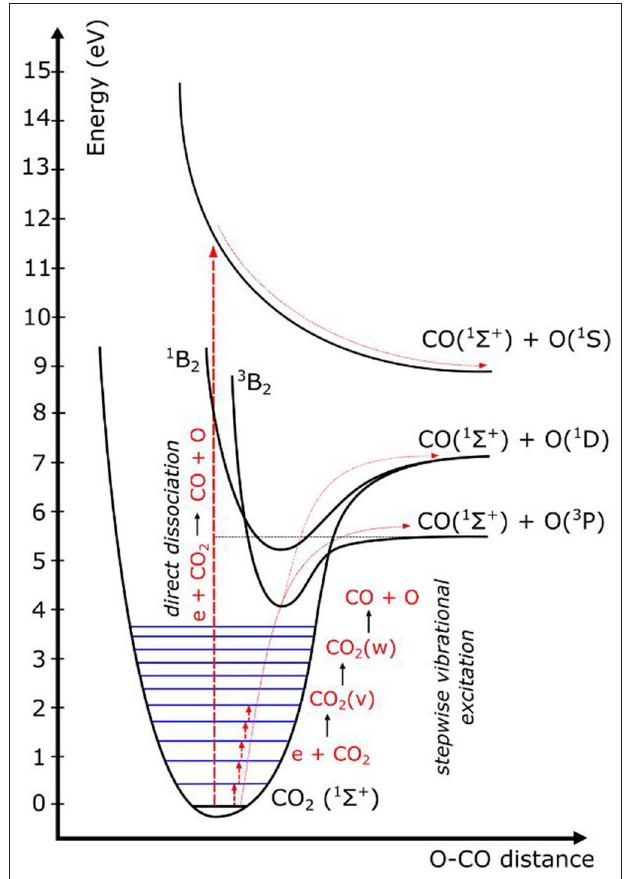
FIGURE 6 | Schematic picture of some CO 2 electronic and vibrational levels, showing that direct electronic excitation–dissociation (as occurs in DBD plasmas) requires much more energy than stepwise vibrational excitation, or vibrational ladder climbing, which is stated to be important in MW and GA plasmas at specific conditions, and which may explain their higher energy